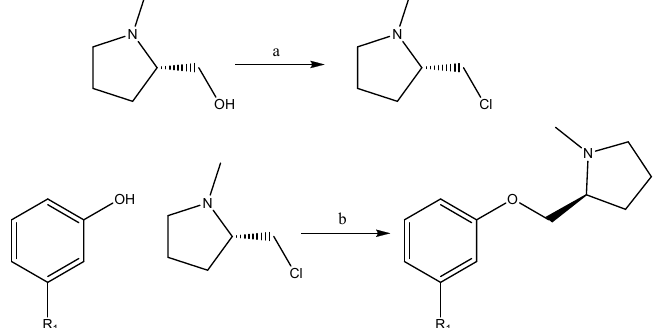
Figure 3. Synthesis Scheme: (a) SOCl 2 , THF-dry, reflux, 24 hours, (b) (S)-2-(chloromethyl)-1- methylpyrrolidine, phenolic derivatives, reflux 48 h, AcCN-dry.